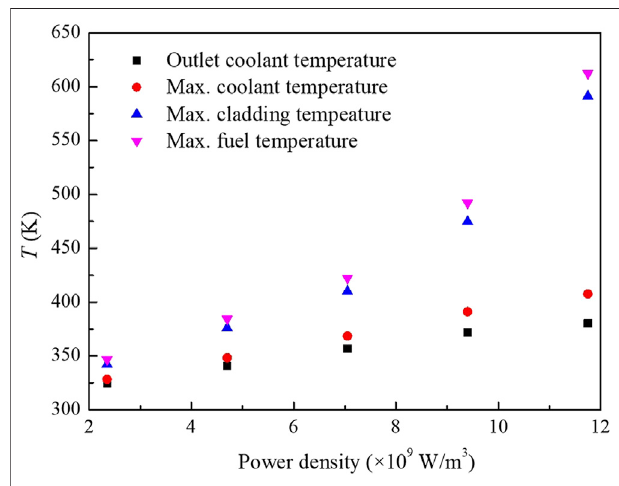
FIGURE 7 | Temperatures of coolant, cladding and fuel with different inlet velocities.